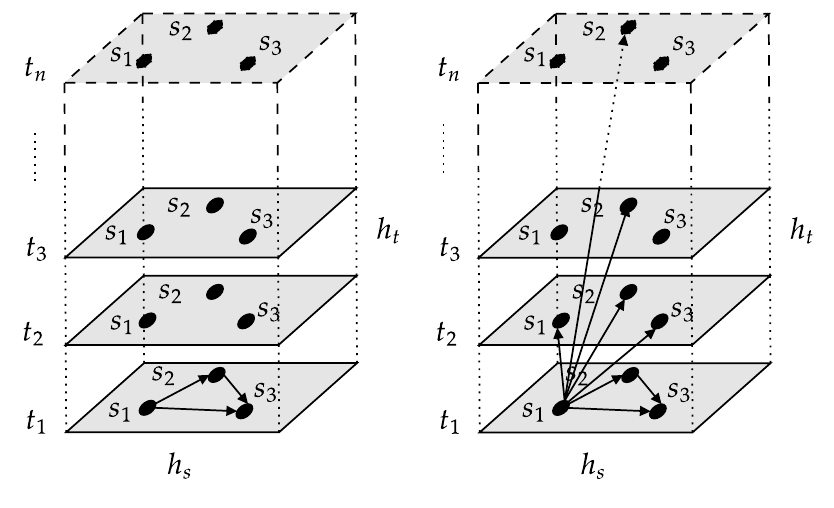
Figure 2. Spatio-temporal